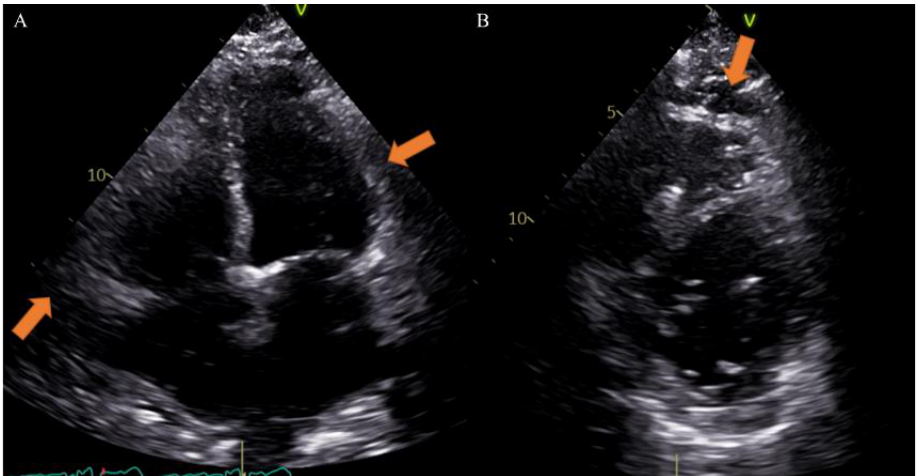
Figure 2. Case of a 65-year-old male patient underwent to echocardiography showing epicardial fat tissue on four chambers (( A ), arrow) and short axis (( B ), arrow) views. From Giuseppe Muscogiuri’s private archive of unpublished cardiac imaging